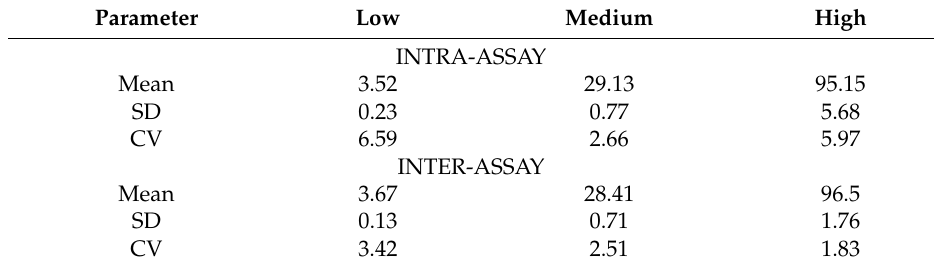
Table 1. Intra- and inter-assay imprecision calculated using pooled sera with low, medium and high